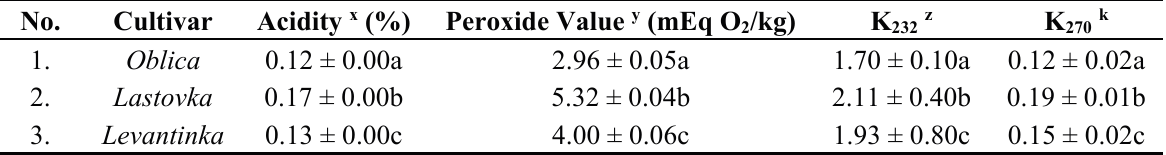
Table 1. Basic characteristics of Oblica , Lastovka and Levantinka virgin olive oils